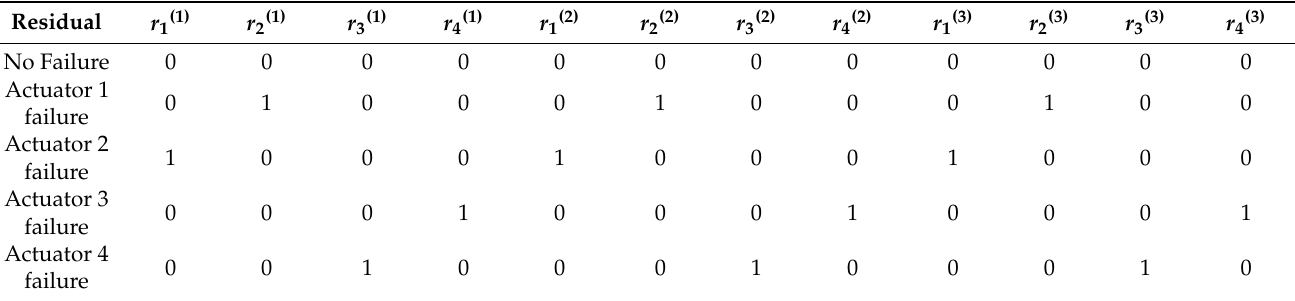
Table 2. Characterization of